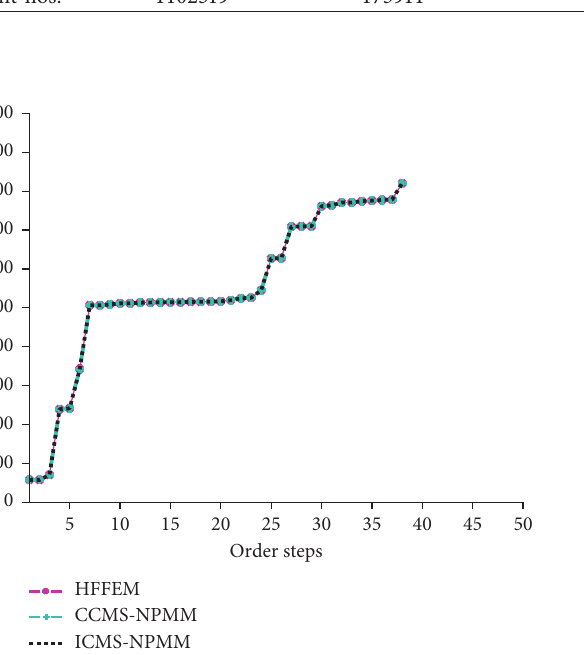
Figure 5: Reduced-order FEM of MTB. (a) Disk cohesion and blade substructure. (b) Blade cohesion and disk substructure. Table 2: The elements of MTB. —— HFEM Classical SCMS Ratio of decline (%) ISCMS Element nos.